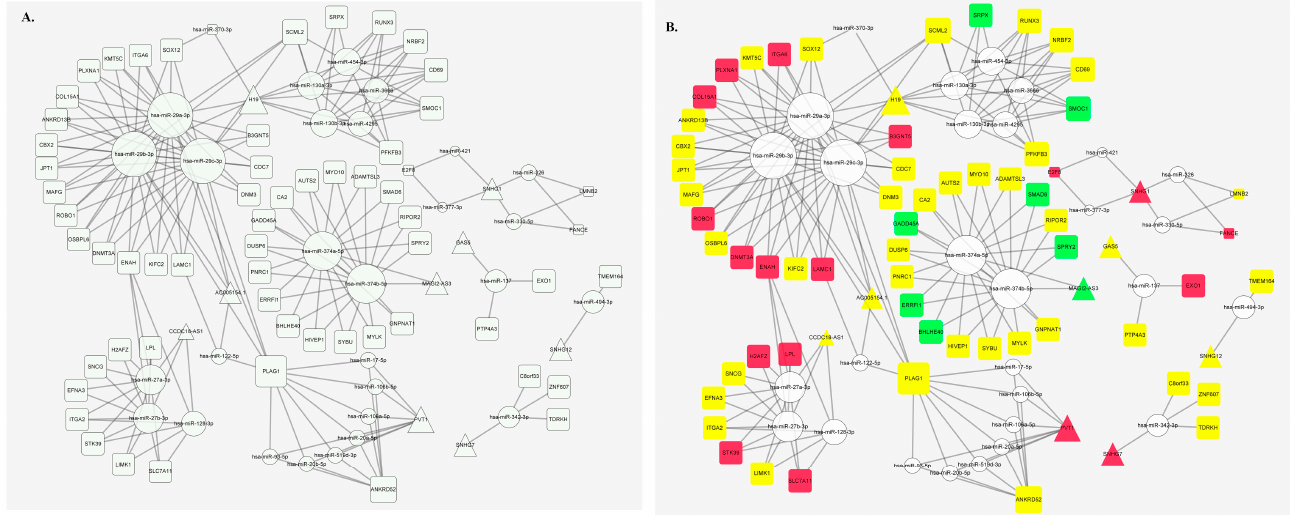
Figure 1. CeRNAs regulatory network. ( A ) ceRNA regulatory network predicted by TCGA. ( B ) potential ceRNA network validation is plotted by microarray. Blank circles represent pre- dicted miRNAs. The green square represents down-regulated mRNA that we detected with a p value < 0.05, the yellow square represents mRNA that we detected with p value > 0.05, and the red square represents up-regulated mRNA that we detected with p value < 0.05. The green triangle represents down-regulated lncRNA that we detected with p value < 0.05, the yellow triangle rep- resents lncRNA that we detected with p value > 0.05, and the red triangle represents up-regulated lncRNA that we detected with p value < 0.05. ceRNA, competitive endogenous RNA. TCGA, the Cancer Genome